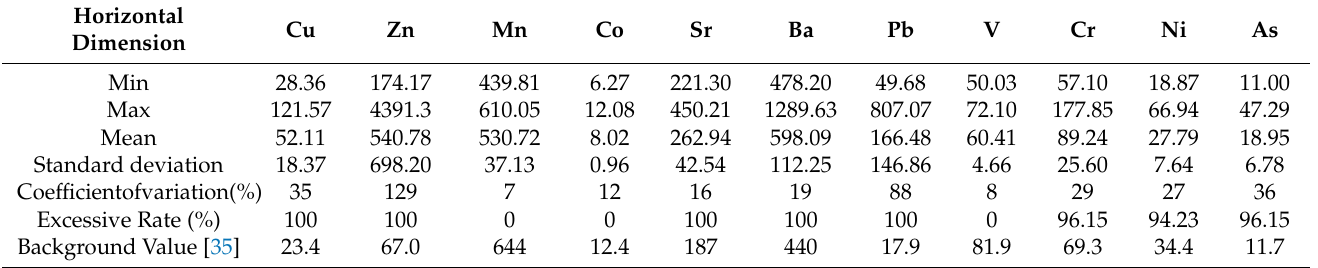
Table 1. The statistical results of the heavy metals concentrations in bus stop surface dust (mg/kg).